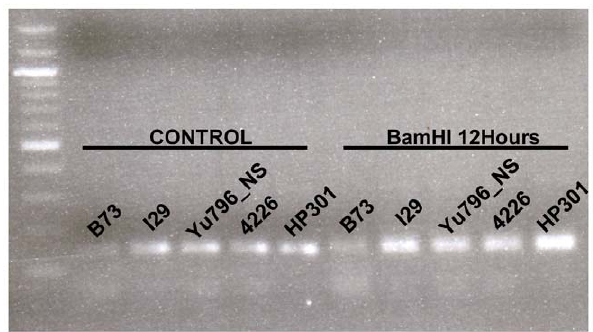
Figure 4. BamHI cut of ZmLOX5 probe to check for a cut site within the probe. To rule out a BamHI cut site in the ZmLOX5 probe used for Southern blotting, the probe was PCR amplified and then cut with BamHI. Shown here is an agarose gel with the untreated control (left) and BamHI treated (right) samples of four of the lines that showed two bands in the Southern blot. There is only one band in the BamHI treated lanes, showing that there is no cut site within the